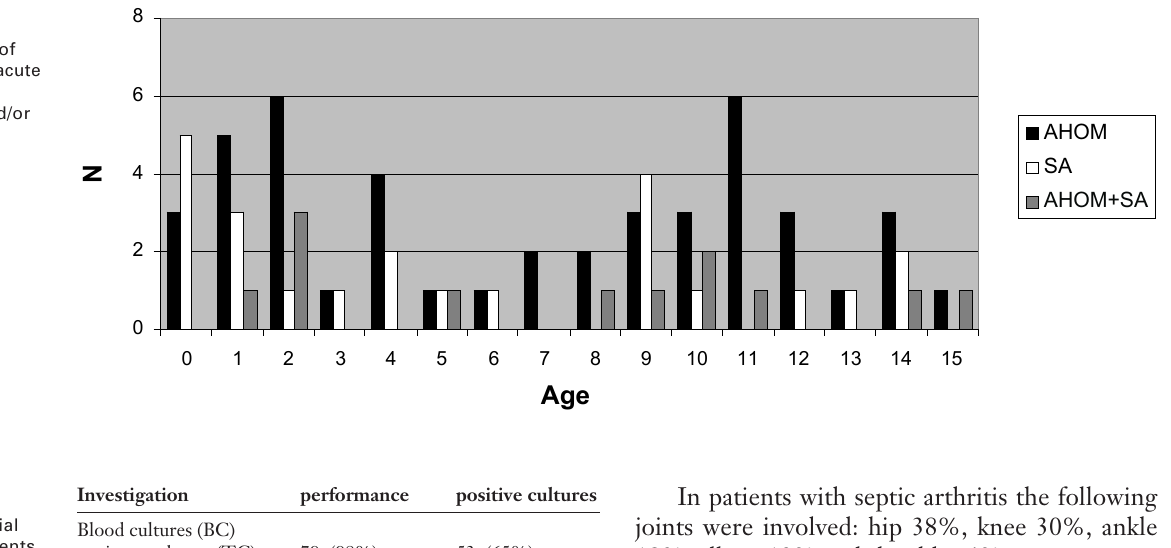
Results of bacterial culture in 81 patients with acute haemato- genous osteomyelitis and/or septic arthritis.